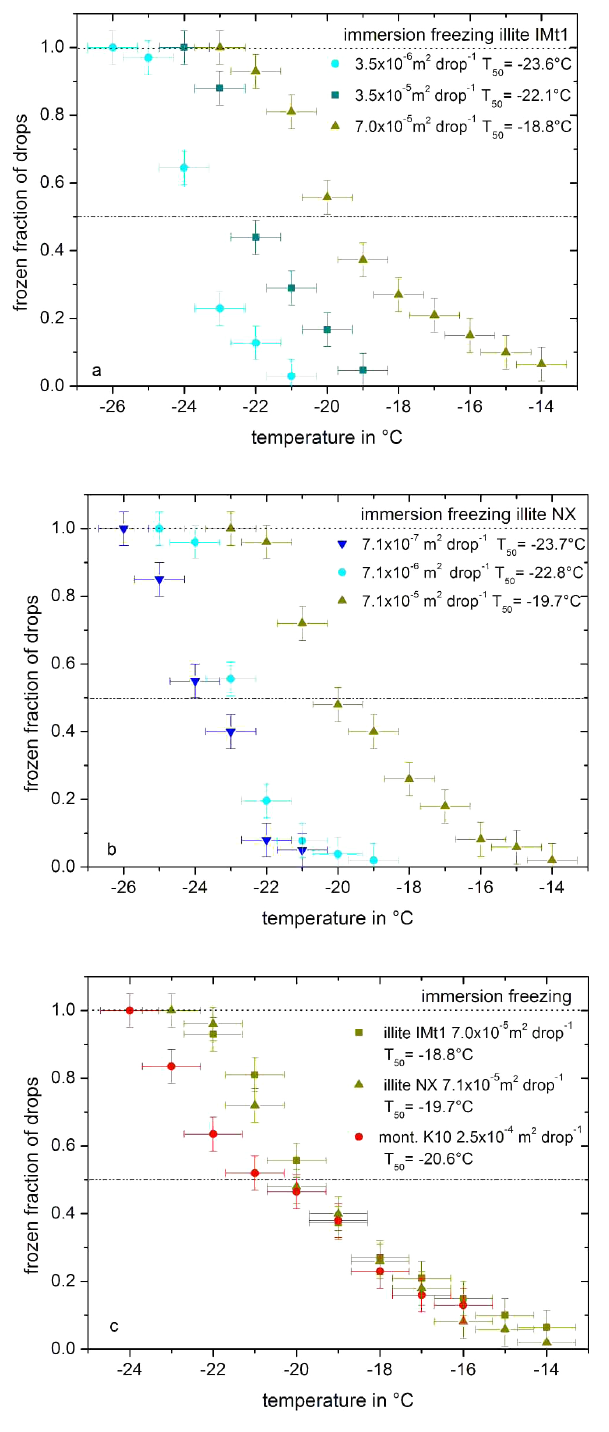
Figure 3. Immersion freezing in the acoustic levitator: frozen frac- tions of drops as function of temperature for different particle sur- face areas per drop. Illite IMt1 (a) . Illite NX (b) . Montmorillonite K10 in comparison to illite (c) .